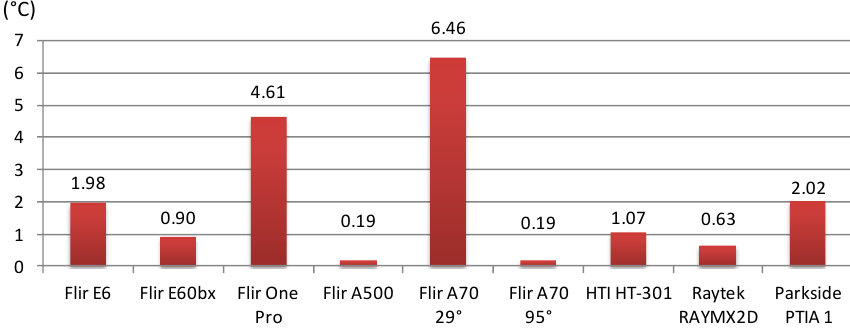
Figure 24. Average deviation in °C for the analyzed thermal cameras.